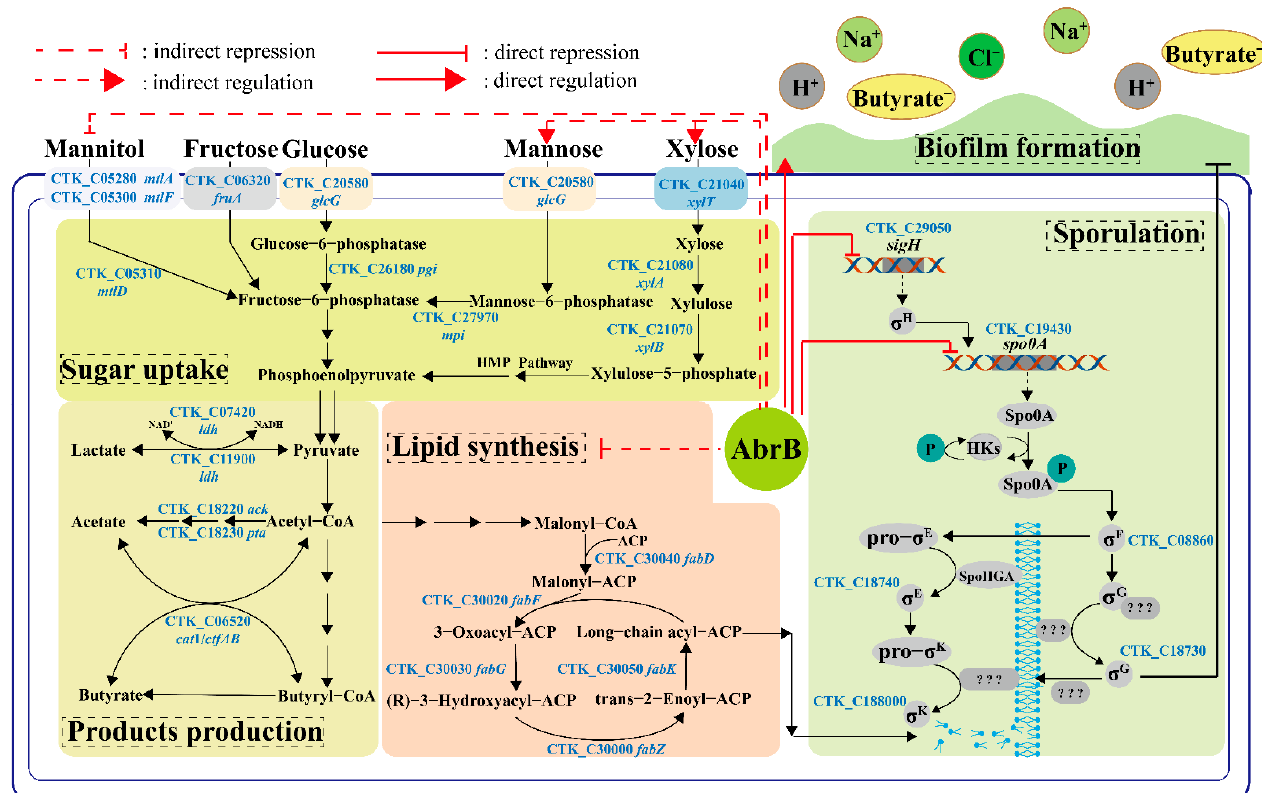
Figure 8. The possible regulatory mechanism of AbrB in C. tyrobutyricum ATCC 25755. Sugar uptake and products production: The utilization of xylose or mannose was repressed while the utilization of mannitol was enhanced when fermentation occurred with a sole carbon source. AbrB could reg- ulate products distribution when mannitol was used as the carbon source. Sporulation and Lipid synthesis: AbrB repressed sporulation by binding to the promoter regions of sigH and spo0A . After abrB knockout, the expression of sigH and spo0A was up-regulated significantly. Meanwhile, abrB deletion alleviated the inhibition of the lipid synthesis pathway and provided raw materials for the synthesis of new cell membranes during asymmetric division and forespore engulfment; Biofilm formation: AbrB directly promoted biofilm formation and improved the tolerance of C. tyrobutyri- cum to adverse environments.